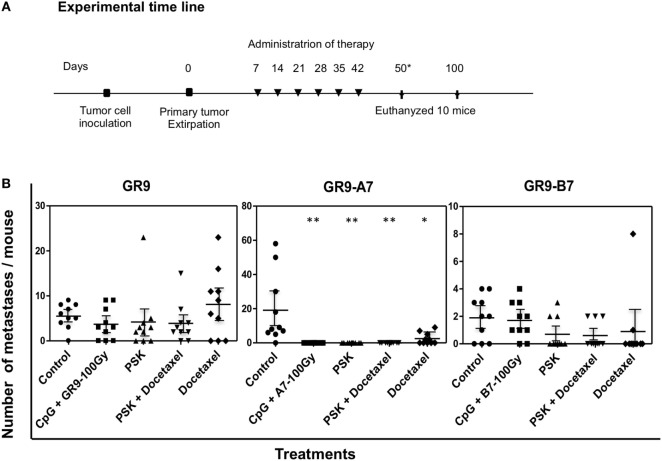
(A) Treatment schedules. Treatments were administered weekly for six consecutive weeks by intraperitoneal injection, beginning at 1 week after removal of the primary tumor. Control groups injected with tumor cells (GR9 or GR9-A7 or GR9-B7) received saline solution as treatment. Ten mice were sacrificed on day 50 post-tumor extirpation to analyze the treatment efficacy. The remaining 10 mice in each group were sacrificed on day100 post-tumor extirpation to evaluate the long-term effect. *Mice in the control and docetaxel groups were sacrificed on day 50 post-tumor extirpation. (B) Spontaneous metastases in tumor-bearing mice receiving the different therapies. The figure shows the pulmonary metastasis count per mouse. These results were reproduced in another two independent experiments. *p < 0.05; **p < 0.01 vs. control. Kruskal–Wallis test, followed by Dunn post hoc test was used for statistical analysis.